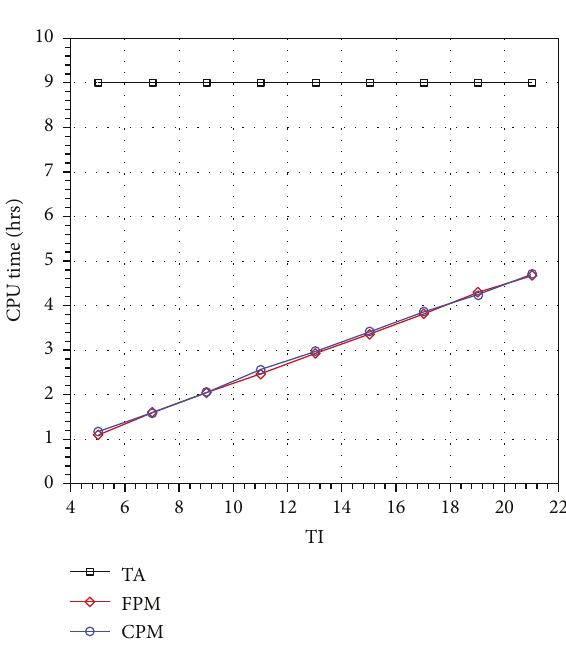
Figure 3: Computational time for NACA 0012 under pitching